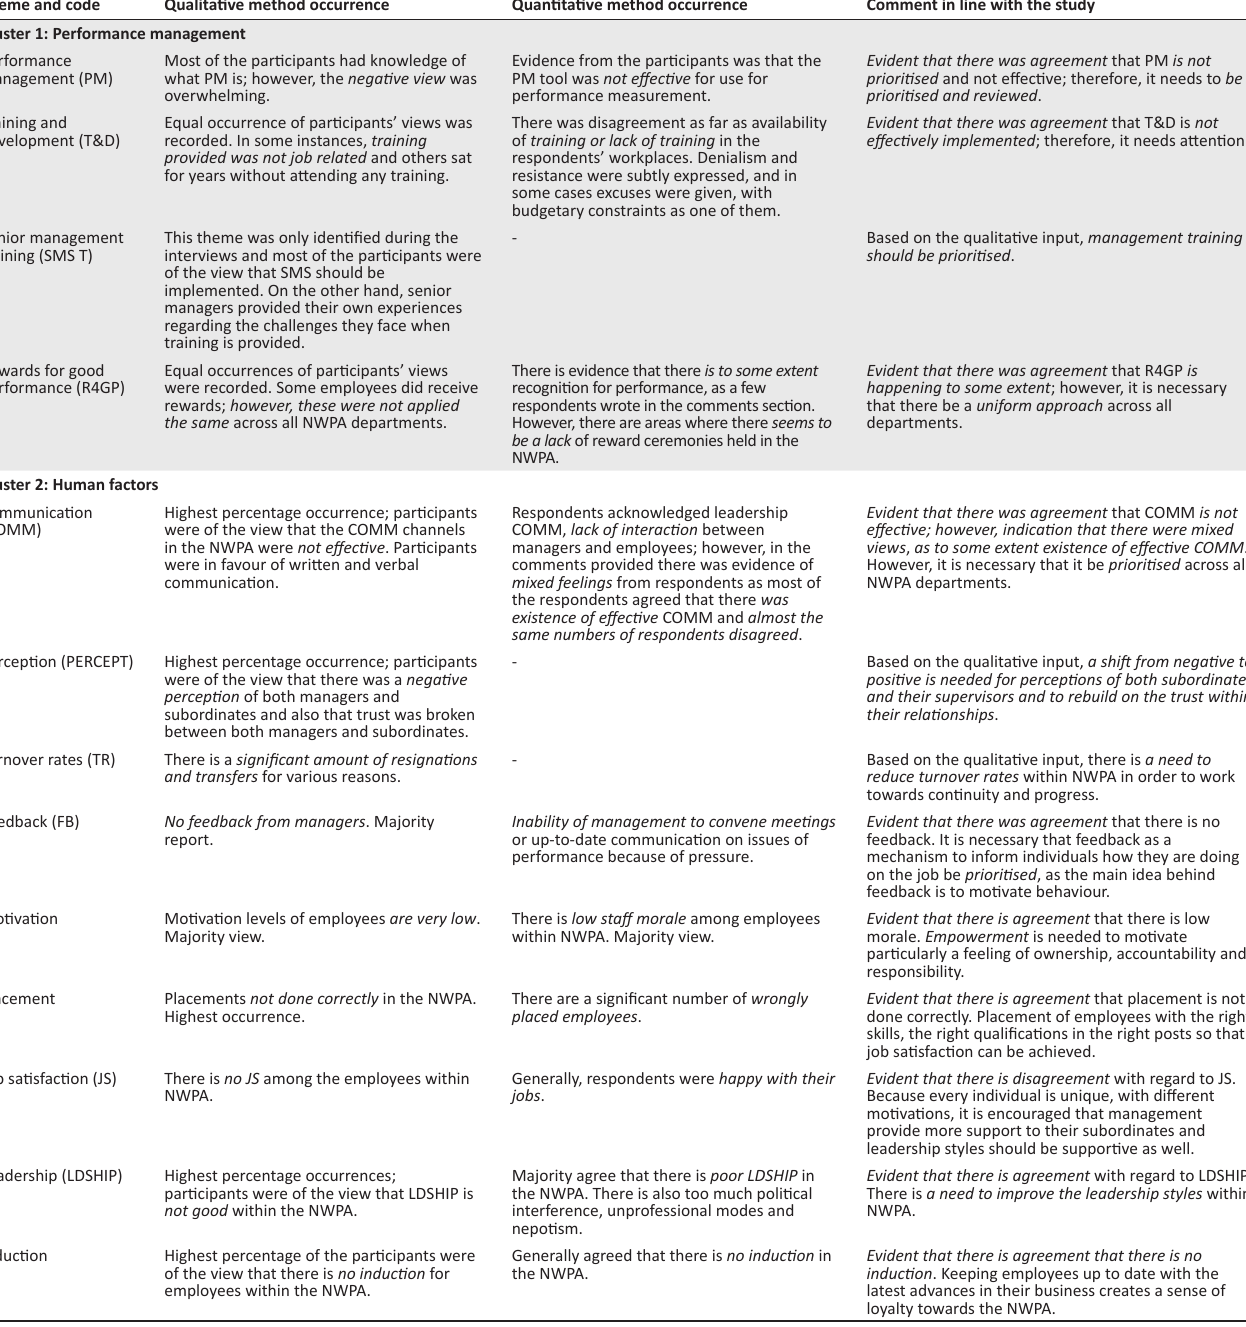
TABLE 4: Integration and comparison of mixed-method